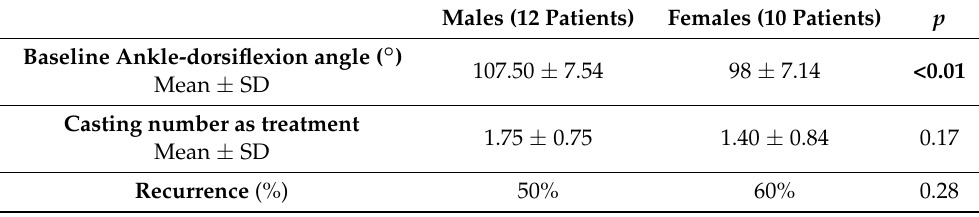
Table 2. Correlation between sex and recurrence (tau-b Kendall), comparison between sex and baseline ankle-dorsiflexion angle ( ◦ ), casting number as treatment (Mann–Whitney U test). Males (12 Patients) Females (10 Patients) p Baseline Ankle-dorsiflexion angle ( ◦ ) Mean ± SD 107.50 ± 7.54 98 ± 7.14 <0.01 Casting number as treatment Mean ± SD 1.75 ± 0.75 1.40 ± 0.84 0.17 Recurrence (%) 50% 60% 0.28